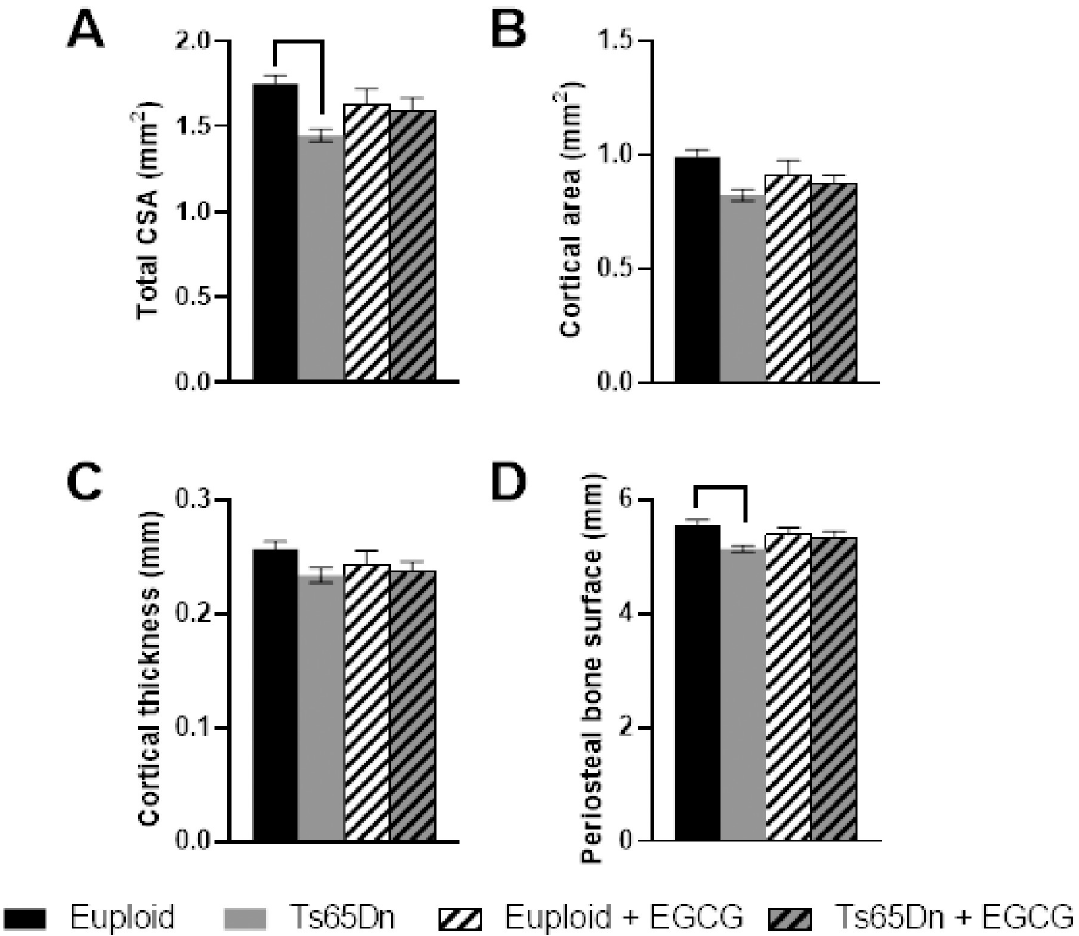
Fig 2. Cortical bone measurements from Ts65Dn and Euploid mice treated with EGCG or control fluid. A. Total cortical surface area (CSA). B. Cortical area (Ct.Ar). C. Cortical Thickness (Ct.Th). D. Periosteal bone surface (Ps.BS). Numbers indicated are average measurements ± standard error of the mean (SEM). Bars indicated differences between groups in post hoc analyses. For numbers of animals and ANOVA results, please see Table